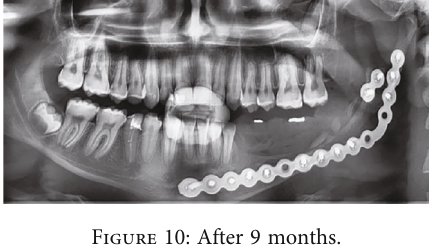
Figure 10: After 9